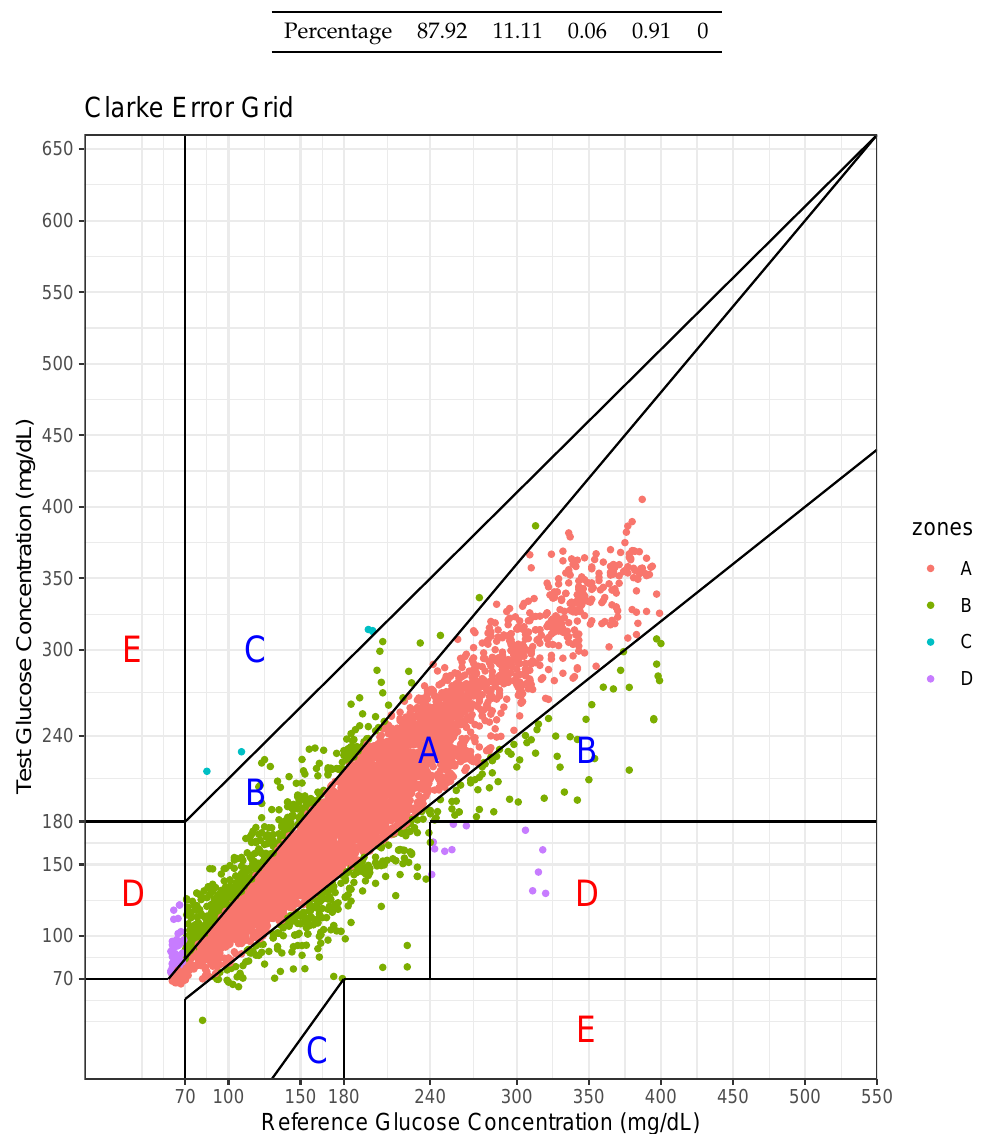
Figure 7. Error analysis with two axes—actual value and predicted